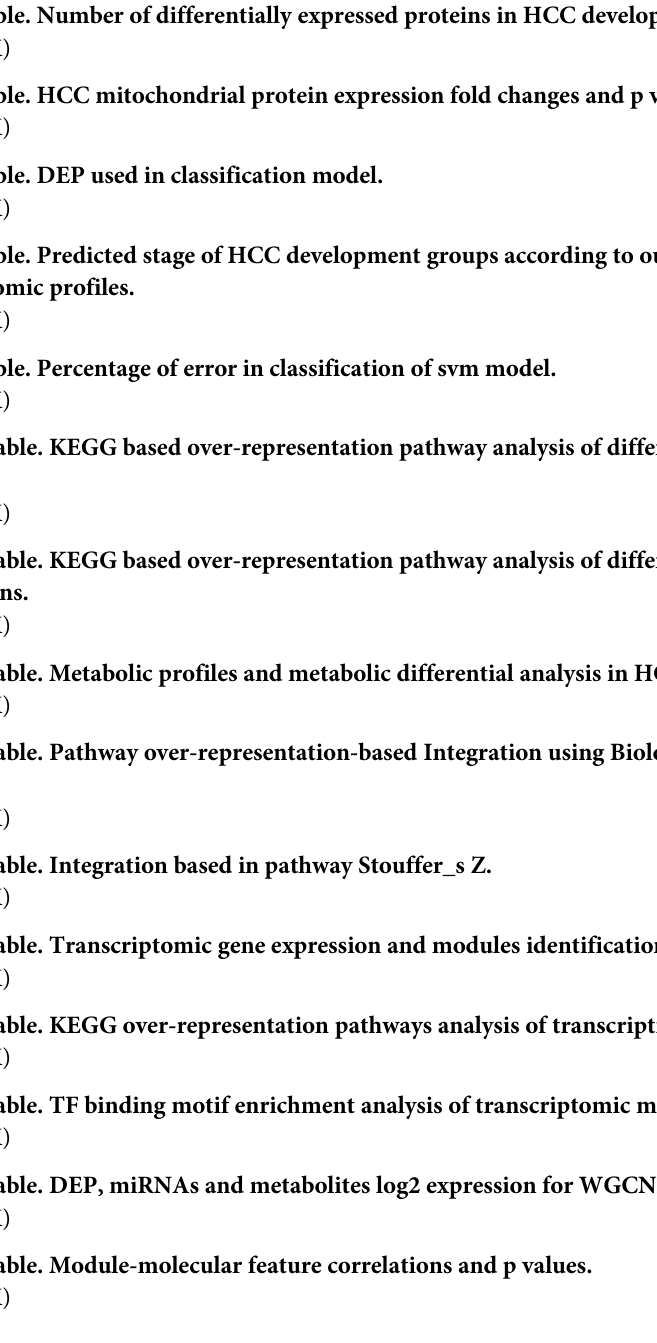
S2 Table. Number of differentially expressed genes in HCC development. S3 Table. iBAQ values of each sample in HCC development. S4 Table. Number of identified proteins in HCC development. S5 Table. Number of differentially expressed proteins in HCC development. S6 Table. HCC mitochondrial protein expression fold changes and p values. S7 Table. DEP used in classification model. S8 Table. Predicted stage of HCC development groups according to our svm model using proteomic profiles. S9 Table. Percentage of error in classification of svm model. S10 Table. KEGG based over-representation pathway analysis of differentially expressed genes. S11 Table. KEGG based over-representation pathway analysis of differentially expressed proteins. S12 Table. Metabolic profiles and metabolic differential analysis in HCC development. S13 Table. Pathway over-representation-based Integration using Biological level expres- sion. S14 Table. Integration based in pathway Stouffer_s Z. S15 Table. Transcriptomic gene expression and modules identification in WGCNA. S16 Table. KEGG over-representation pathways analysis of transcriptional modules. S17 Table. TF binding motif enrichment analysis of transcriptomic modules. S18 Table. DEP, miRNAs and metabolites log2 expression for WGCNA based integration. S19 Table. Module-molecular feature correlations and p